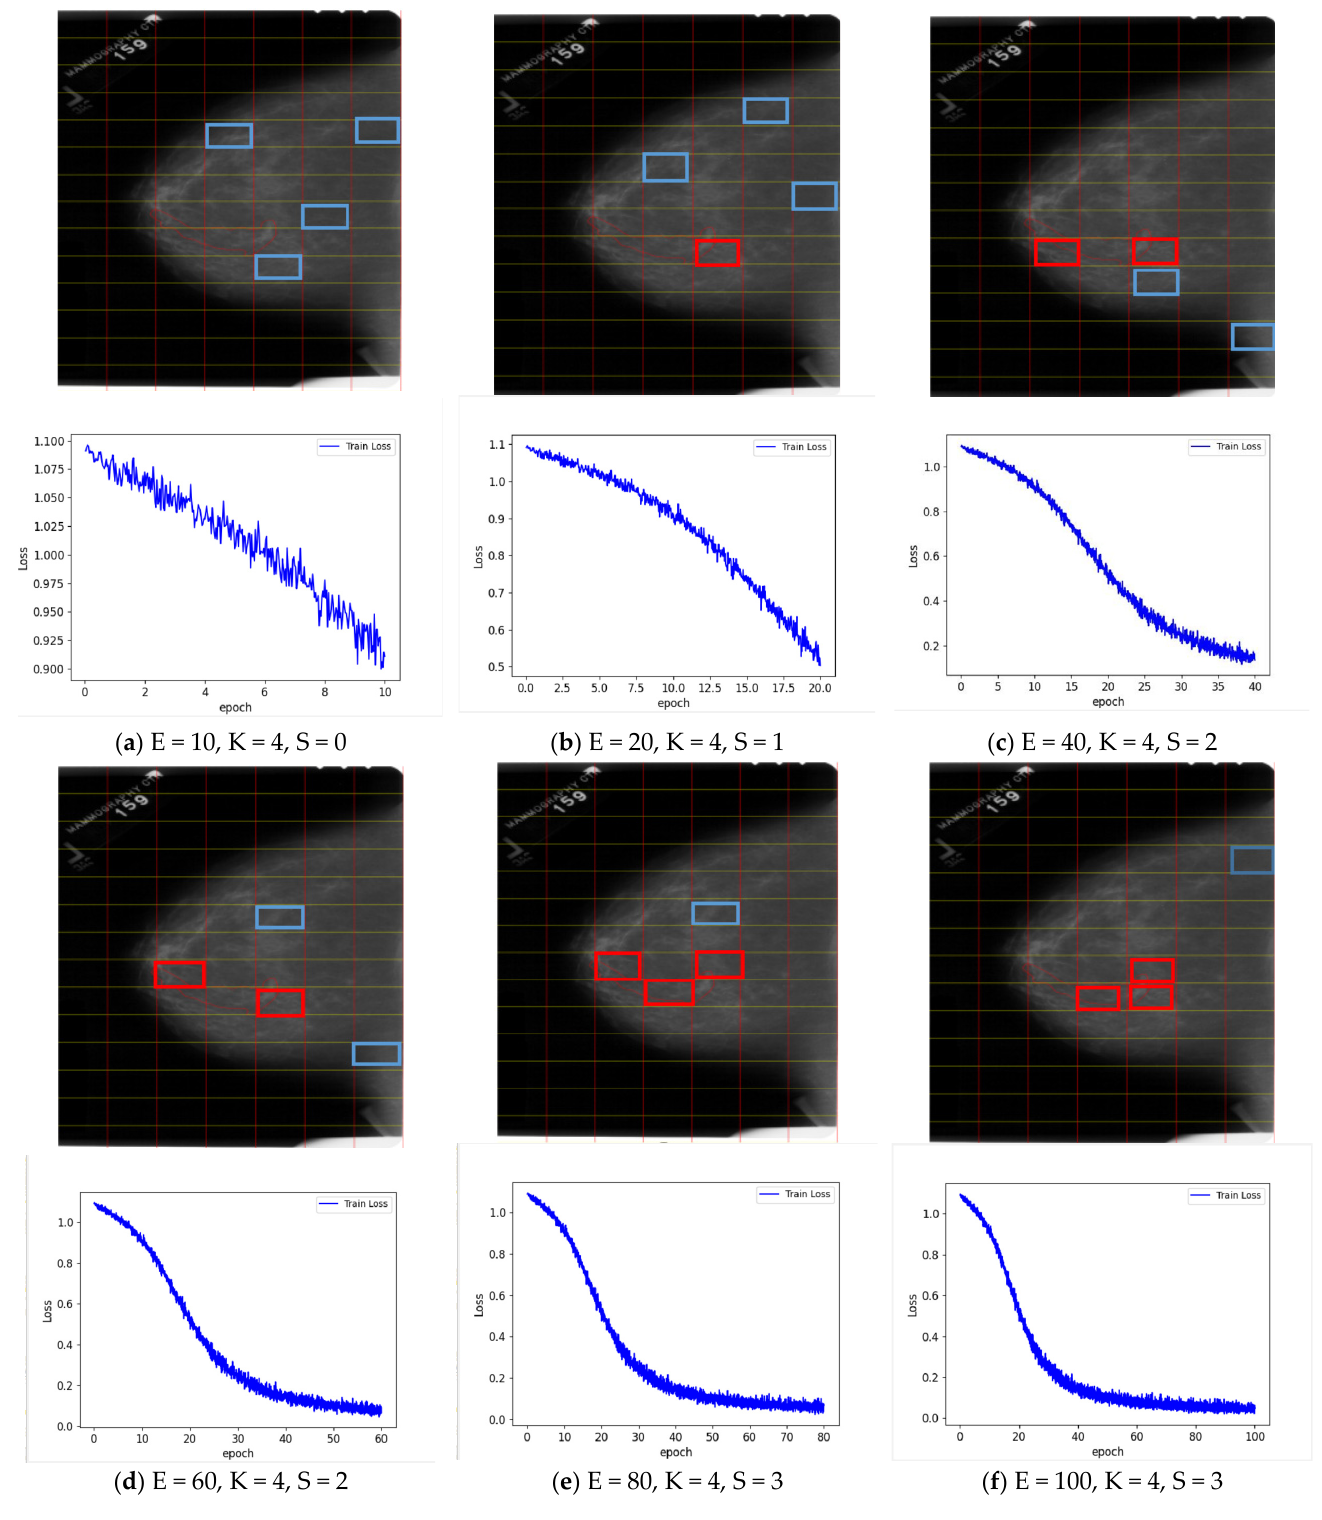
Figure 3. When the key instance K value is 4, the number of positive instances S in the key instances selected by the model and the model training loss change as the epoch E increases E, K, and S represent epoch times, key instance, and positive instance in key instance, respectively. The key instances marked with a blue rectangle denote false instances, whereas the red rectangles represent true